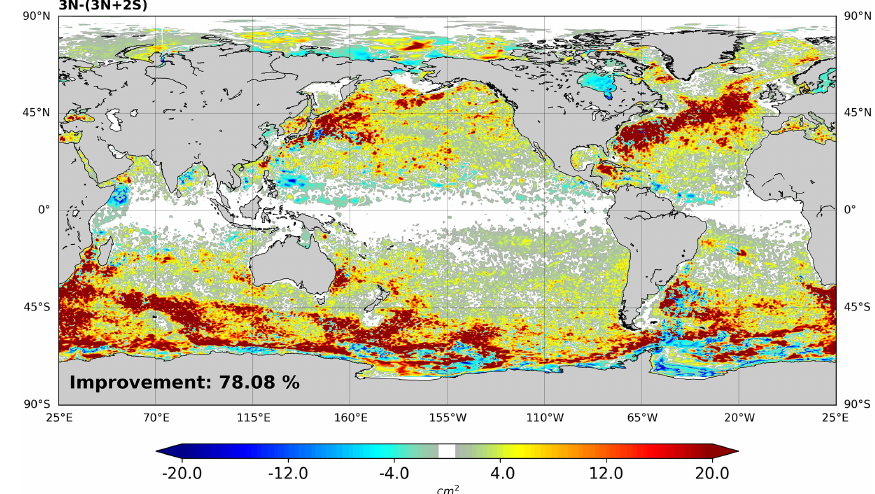
Figure 6. Difference between analysis error variance of assimilation with three nadirs (3N) and assimilation of three nadirs and two wide- swath altimeters (3N +